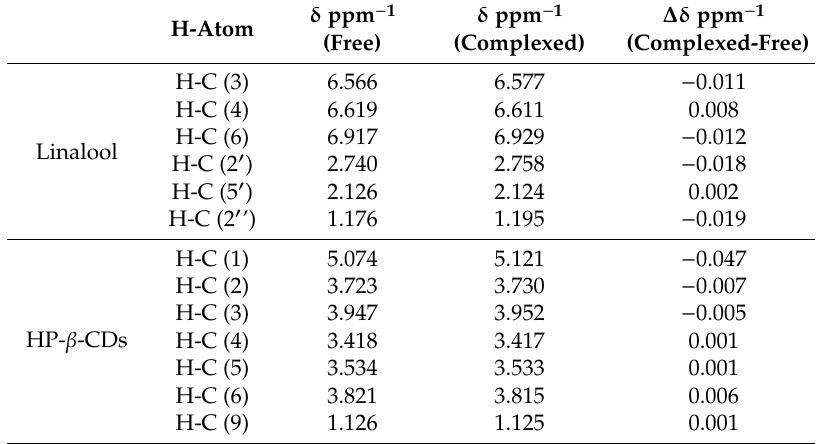
Table 2. Chemical shift of linalool and HP- β -CD both in its free form and complexed in methanol-d 4 .